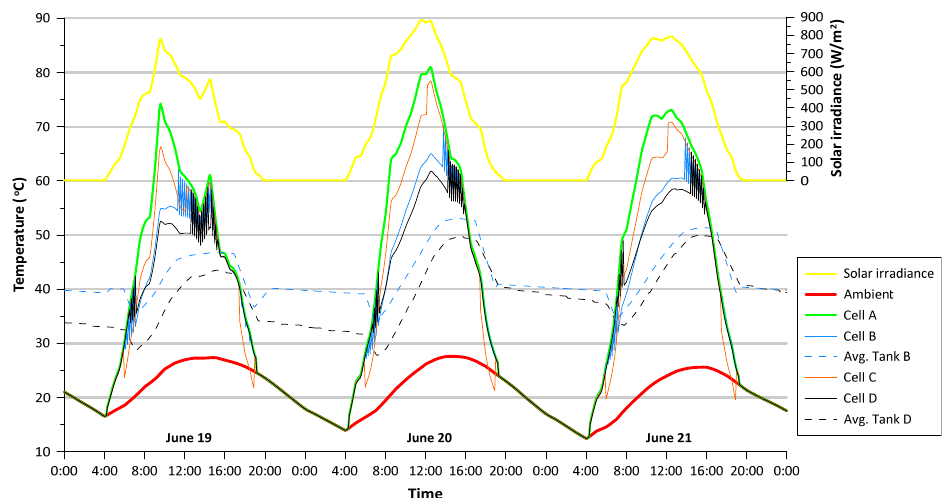
Figure 5. Changes of average cell temperature for (cid:2010) equal 0.005: ( a ) Models A and B; ( b ) Models C and D.